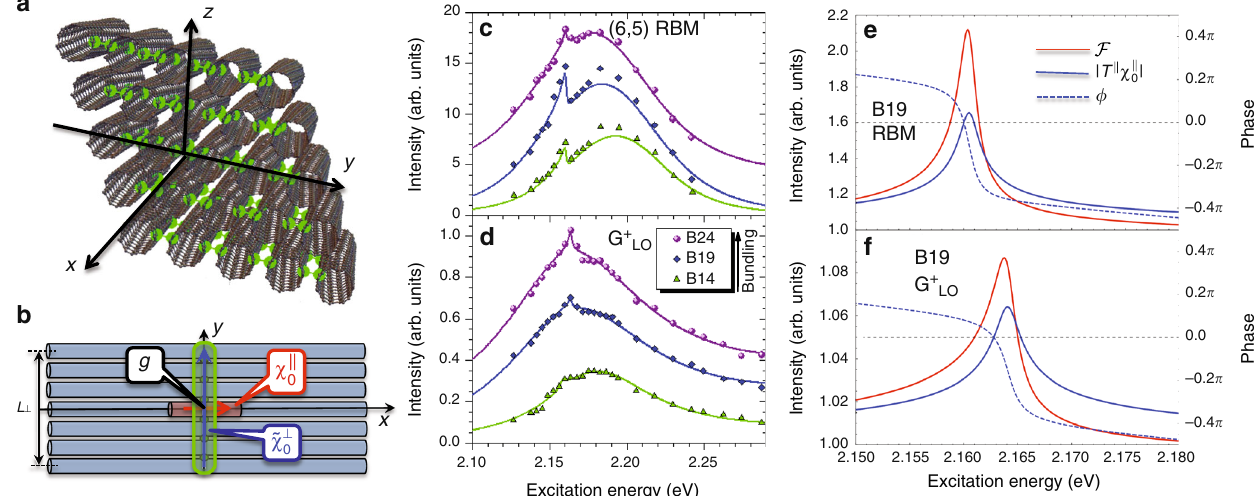
Fig. 3 Model for intertube exciton generation in (6,5)-SWCNT bundles and origin of Fano resonance via coupling of intertube and intratube excitons. a Optimized (6,5)-SWCNT bundle structure obtained via molecular dynamics simulations. Atomic sites of adjacent tubes separated by van der Waals distance d 0 ≤ 3.14 Å are marked in green. These sites participate in the intertube electron/hole tunneling facilitating formation of the intertube exciton state. b The xy -plane cross-section of the bundle. Red cylinder marks the intratube exciton state polarized along the tube axes as indicated by the red ð ω Þ . Green area marks an intertube exciton state delocalized across L arrow. It gives rise to the Raman polarizability χ jj ⊥ tubes and polarized (blue arrow) 0 ð ω Þ . Local coupling, g , between the two types of excitons at the intercept point gives rise across the bundle. This state results in the Raman polarizability ~ χ ? 0 to their scattering. Fano resonance appears as a signature of the bright intratube exciton scattering by the dark intertube exciton. c , d Experimental data fi t (solid lines) using our theoretical model [Eqs. (5) and (6)]. e , f Fano lineshape function (red), the absolute values of the scattering term (blue solid), and the scattering phase (blue dash) calculated using parameters obtained from experimental data fi t for the B19 bundle RBM and G þ modes, respectively. LO Positive (negative) phase values de fi ne spectral regions of constructive (destructive)